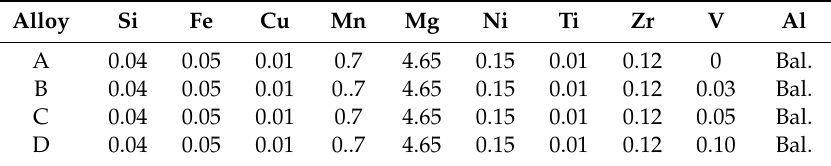
Table 1. Chemical composition of experimental alloys (in